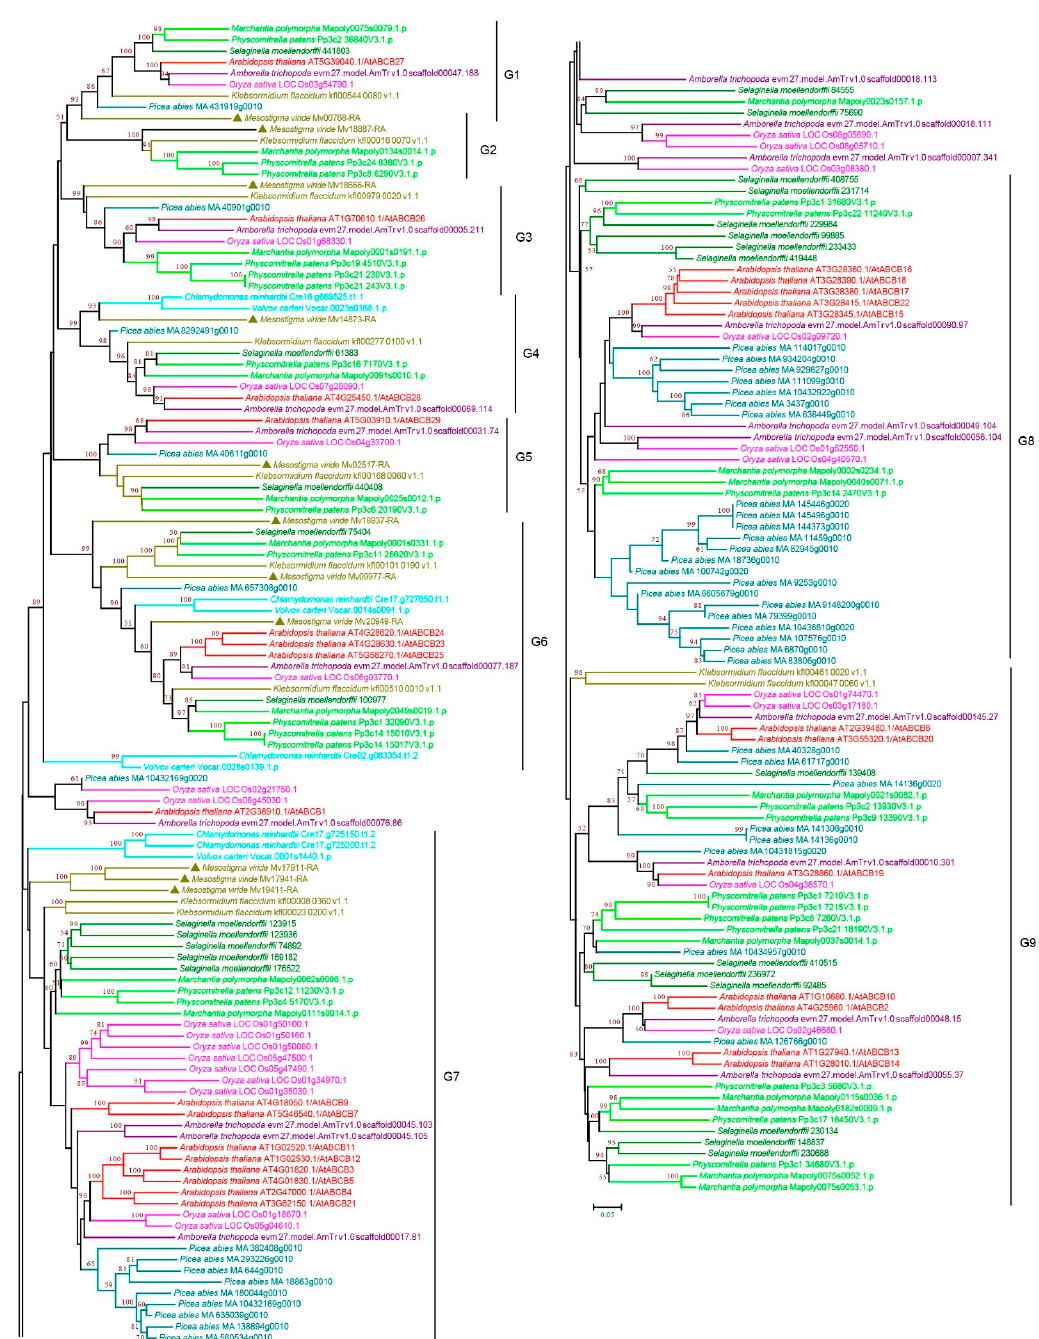
Figure 3. Phylogenetic analysis of ABCB subfamily proteins from 11 evolutionarily representative plant species. A neighbor-joining (NJ) tree was generated using MEGA7 with 1000 bootstrap replicates, and bootstrap values >50% are shown on the branches. The M. viride proteins are highlighted by triangles.